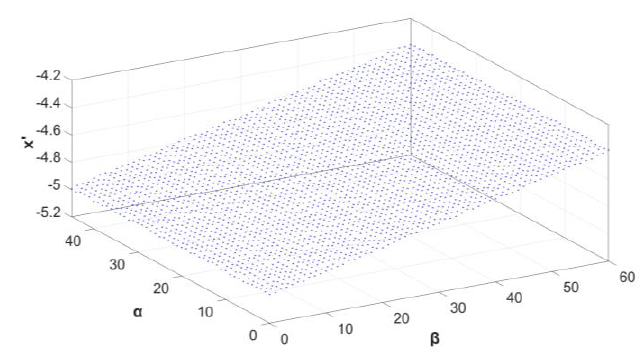
Figure 11. Results of the sensor’s simulated response.